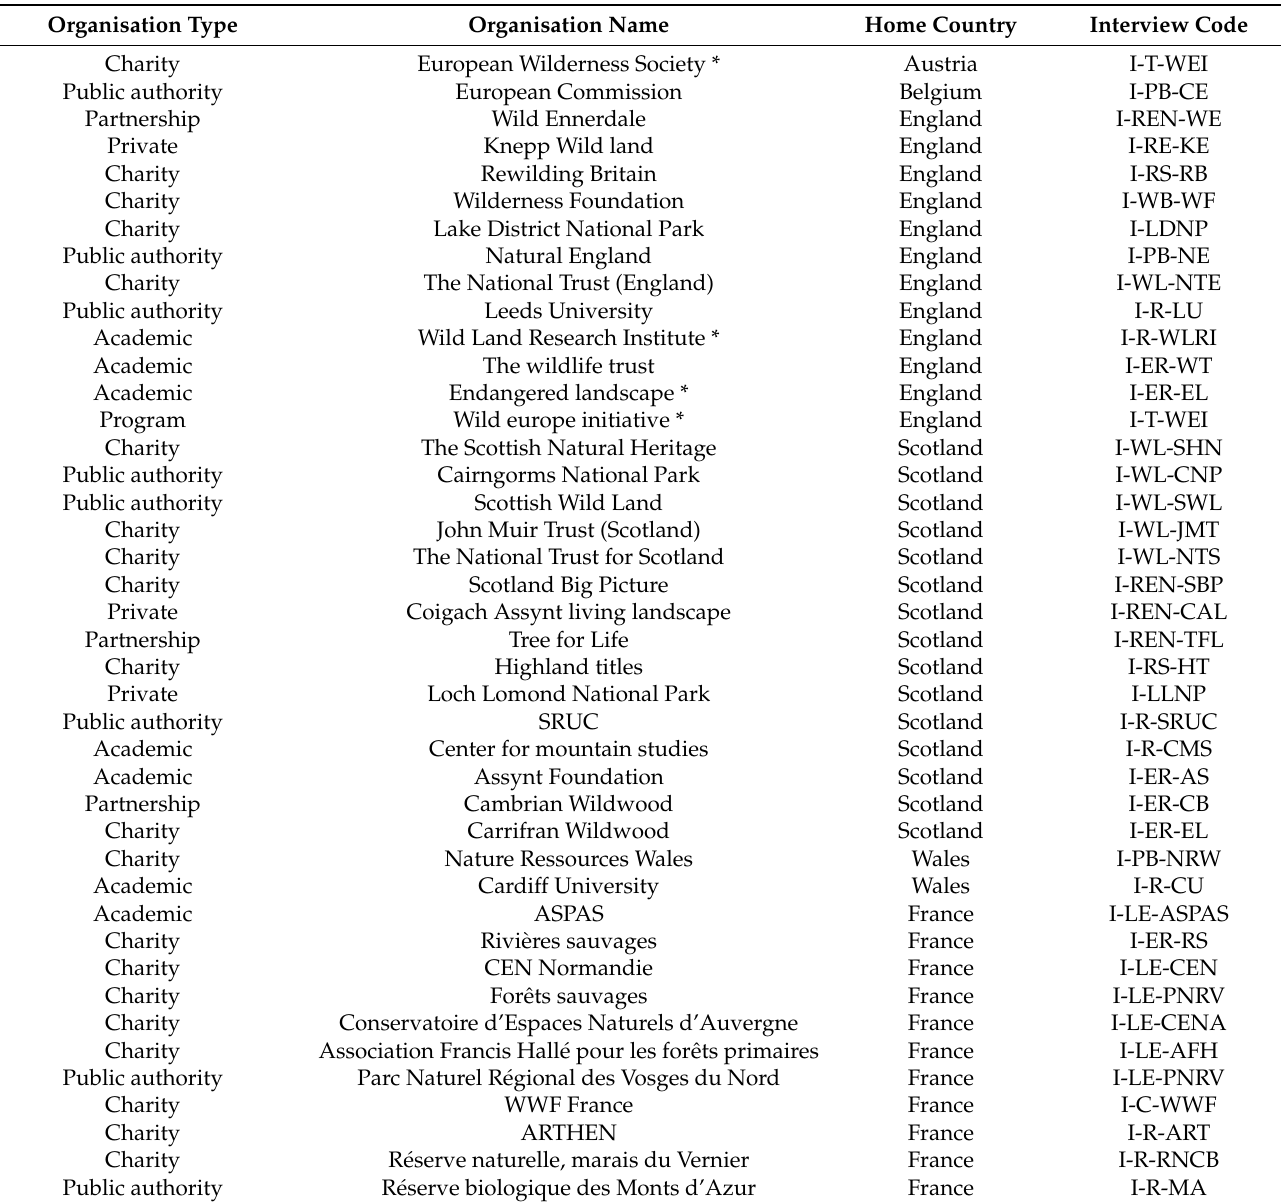
Table 3. List of studied